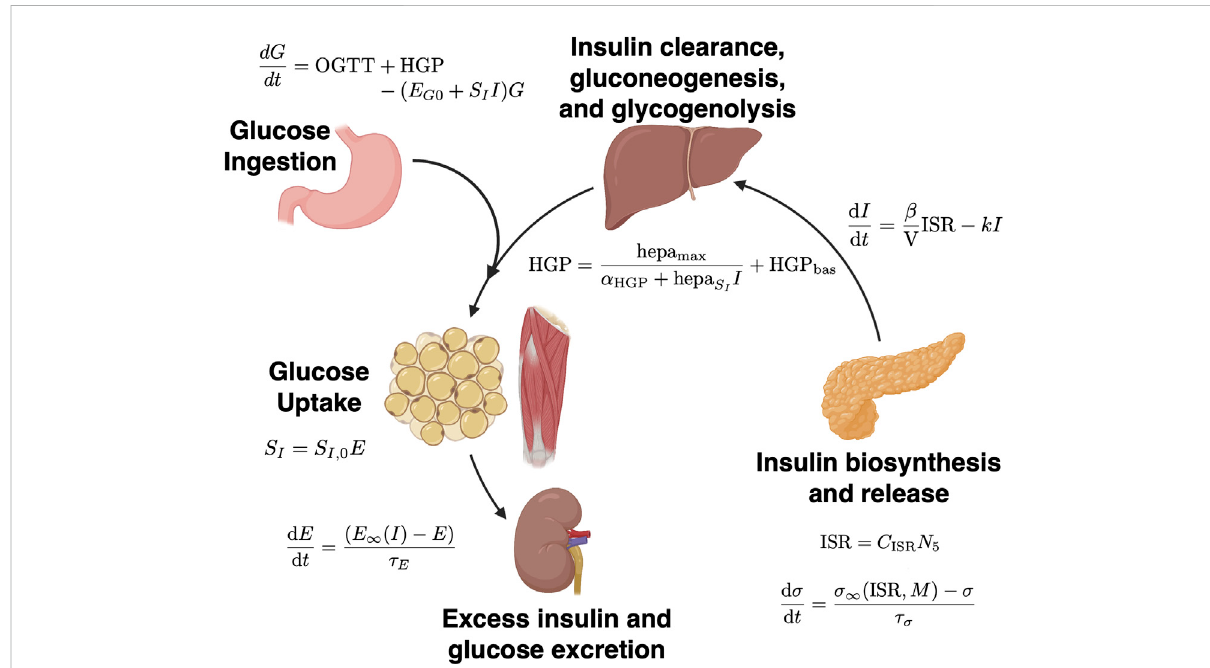
FIGURE 1 Schematic of mechanistic models of glucose metabolism. Underlying physiologic processes are represented by a series of ordinary differential equations (ODEs). Solutions lie on discrete spaces based on patient physiology at the time of measurements. In data assimilation, after reverse parameterestimationatdiscretetimepoints(i.e.,insulinsecretioncapacity, σ ,andinsulinsensitivity,S I ),thesystemstateisupdatedandtheODEsare solved again. Figure adapted from Tokarz et al. (Tokarz et al., 2018) and created with BioRender.com. Relevant equations are outlined in Methods and in Ha and Sherman 2020 (Ha and Sherman,